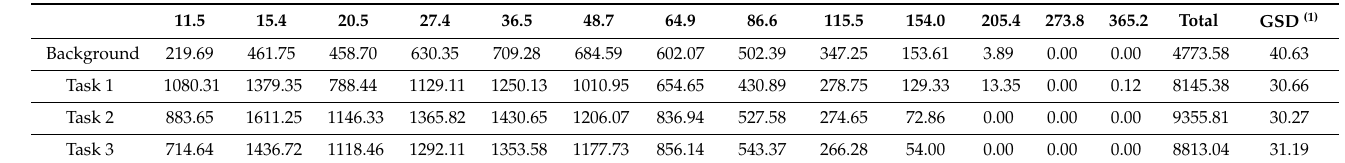
Table 4. Results provided by the SMPS: Mean particle number concentration (particles/cm 3 ) by particle size.